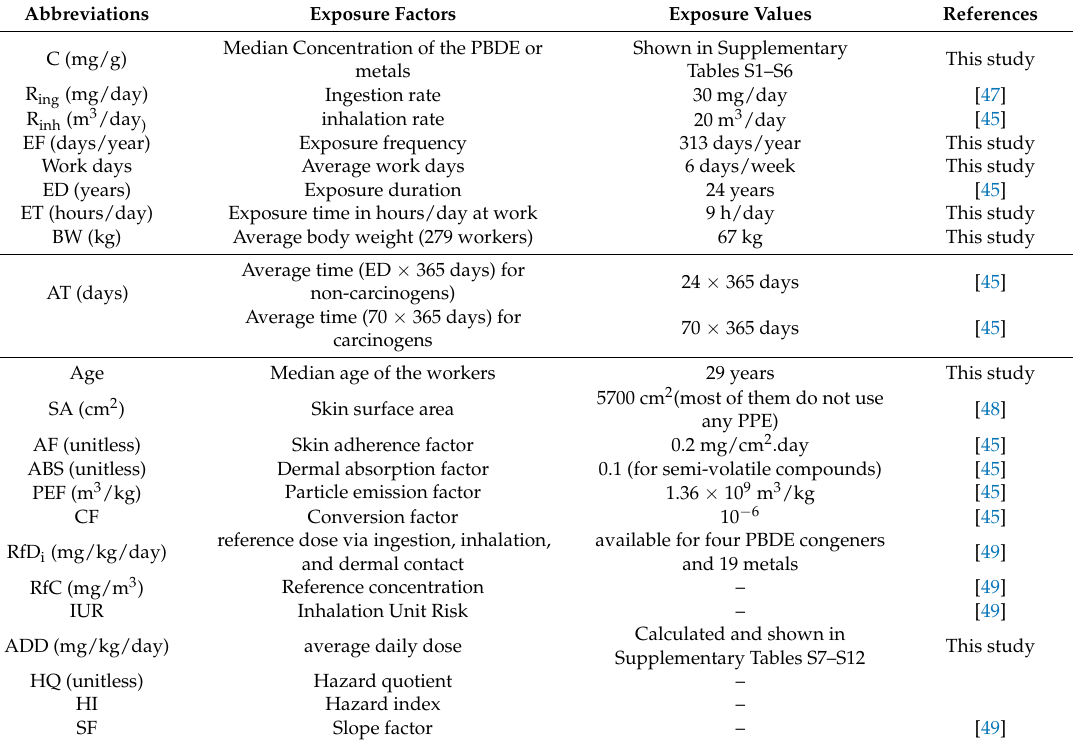
Table 2. Exposure parameters for adults ( e -waste workers) with associated